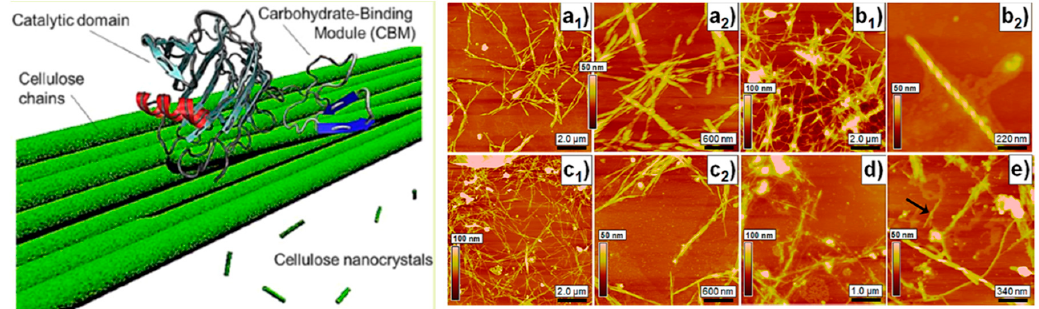
Figure 5. Process of enzymatic hydrolysis of bacterial cellulose left: mechanism of enzymatic hydrolysis, right: Atomic force microscopy height images of hydrolyzed BC after 74 h according to the following enzyme/BC ratios. Reprinted with permission from Ref. [79]. Copyright 2018 American Chemical Society.